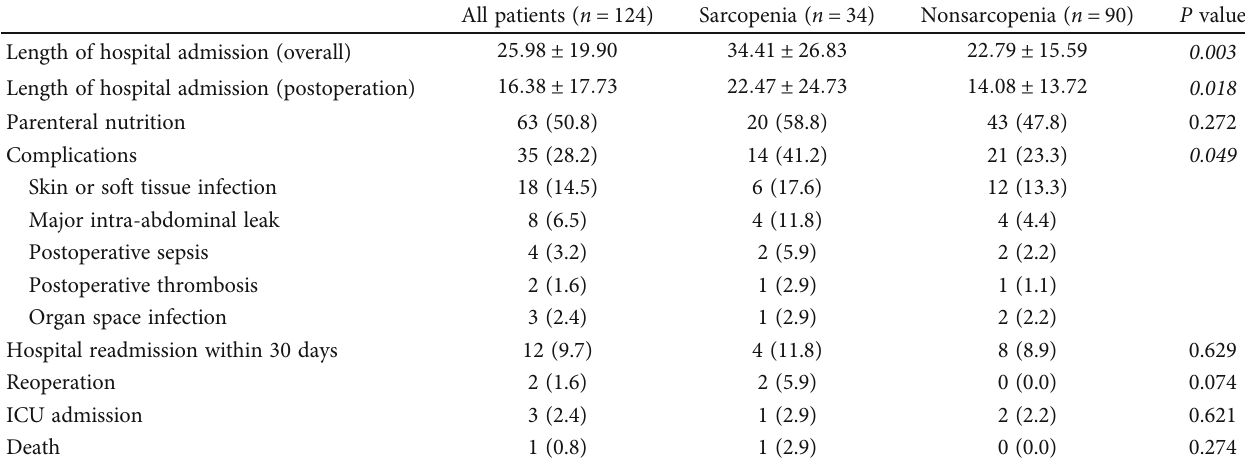
Table 3: Analysis of postoperative outcomes and complications in CD patients with or without sarcopenia. All patients ( n = 124